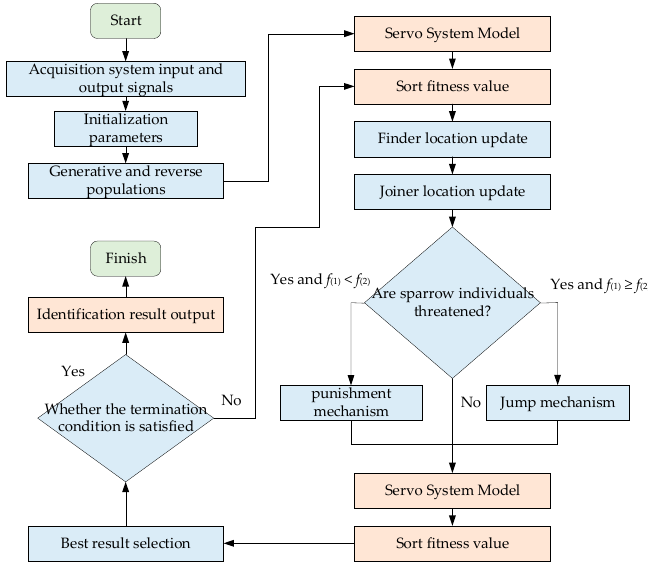
Figure 6. System identification flow